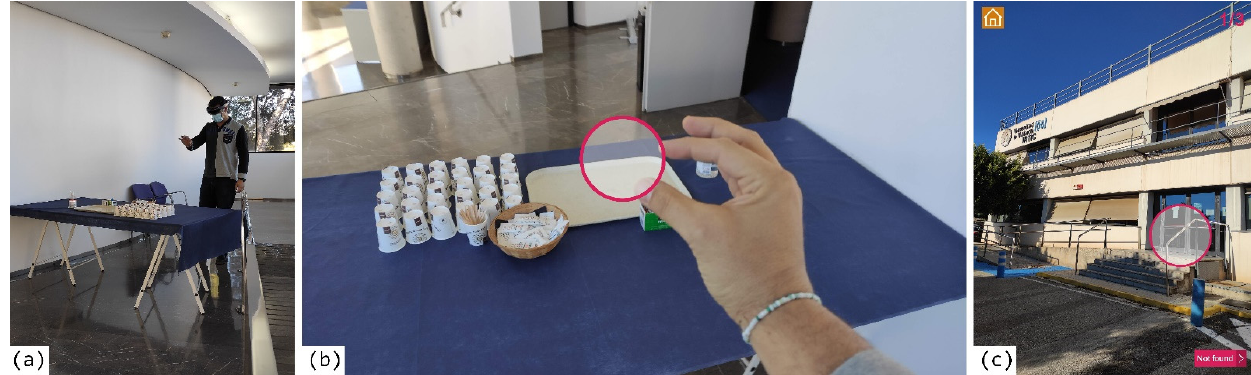
Figure 1. Testing our AR annotation method in different scenarios with different devices: HoloLens ( a , b ) and iPad ( c ).